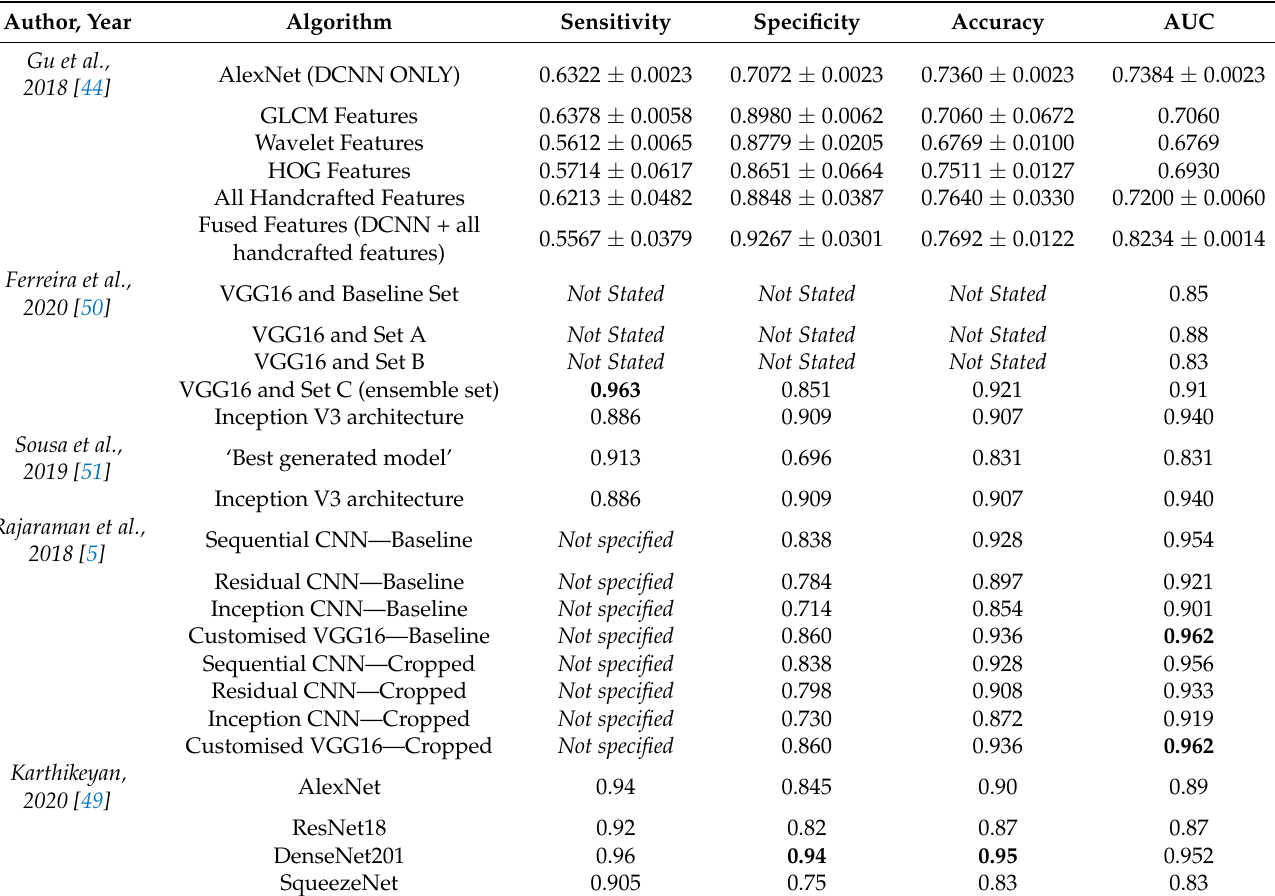
Table 2. The diagnostic accuracy of each AI algorithm employed in its respective paper in terms of sensitivity, specificity, accuracy, and AUC (area under the curve). The highest value for each outcome measure is highlighted in bold. ± indicates the standard